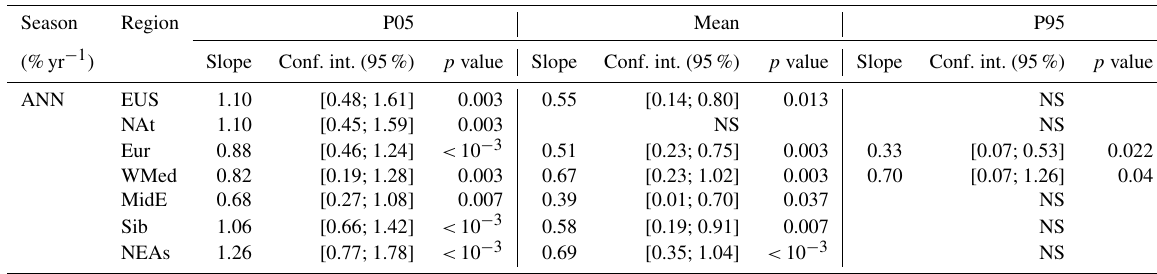
Table D3. O 3 relative trends in %yr − 1 during all the year in the UT. From left to right, the anomalies are taken from deseasonalized P05, monthly means, and P95. The insignificant trends with respect to the 95% confidence level are indicated as NS. Season